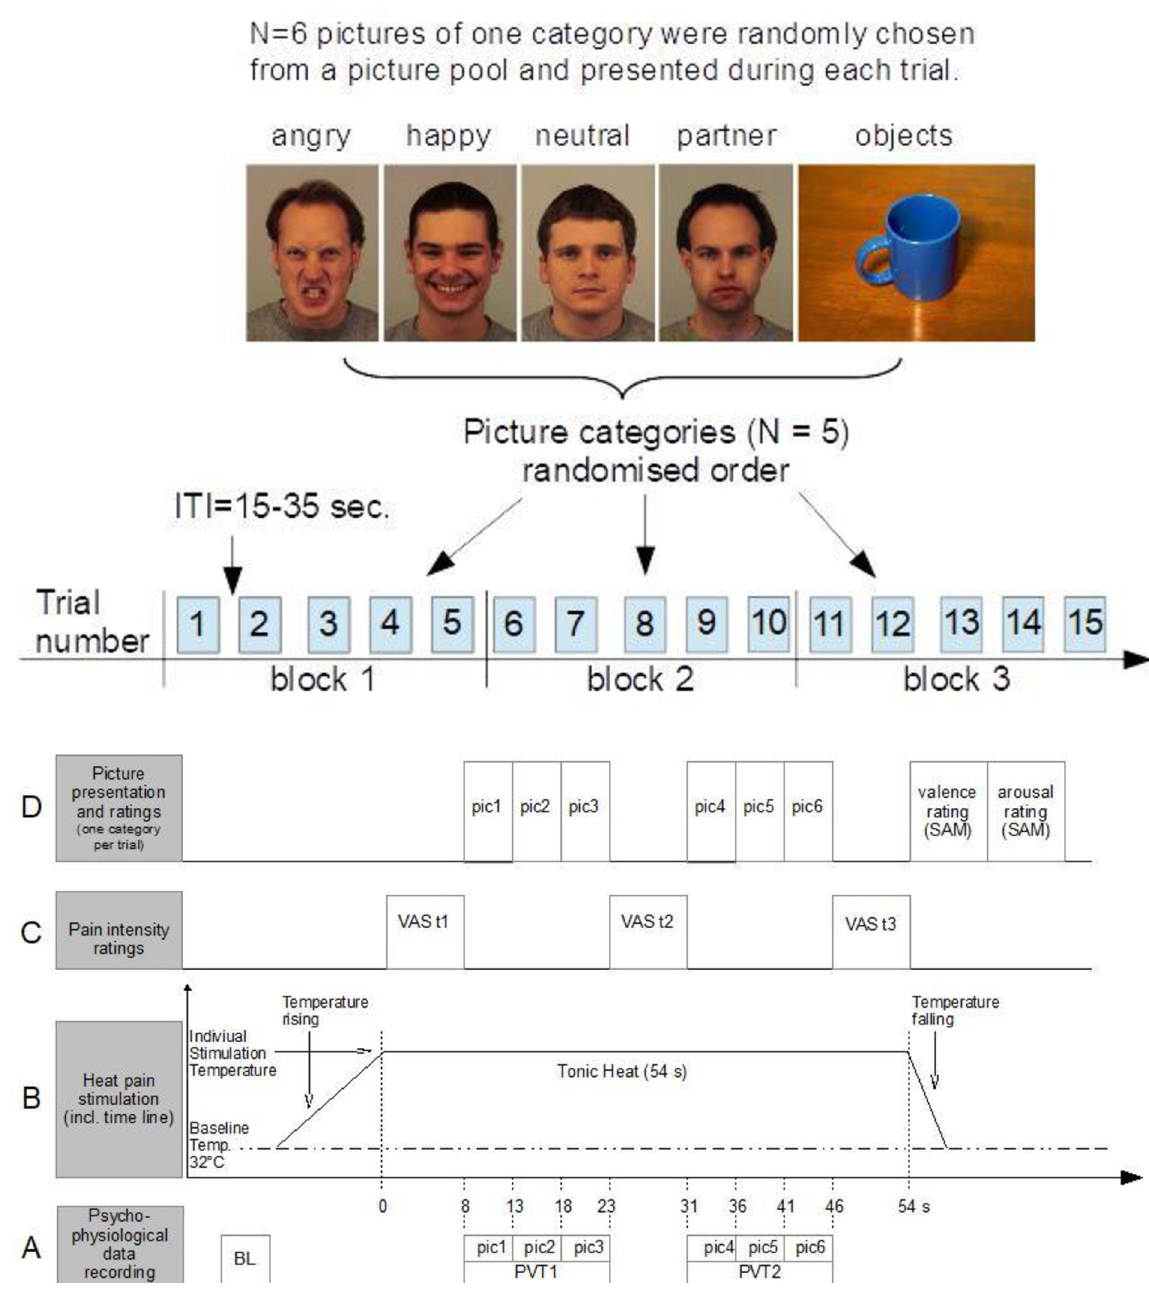
Fig 1. a. Experimental design. Each picture category was presented three times (block 1–3). In each block, the order of the five picture categories was randomized for every participant. Inter-trial-intervals (ITI) varied between 15 and 35 s. Image codes of the schematically displayed pictures (from left to right): AM10ANS, AM31NES, AM07HAS, instead of the picture of the partner the picture AM02NES is presented, due to picture rights, 7009. b. Trial structure. The figure shows the time course of one experimental trial. (A) Psychophysiological data were recorded continuously and later segmented (BL: baseline, 5s before temperature rising, pic1-pic6: 6 5 s intervals during picture presentation, PVT: picture viewing time), (B) heat pain stimulation: starting from a baseline temperature of 32˚C, temperature increased at a rate of 1˚C/s until reaching the individually adjusted stimulation temperature. The target temperature was held constant for 54 s and then returned to baseline temperature at a rate of 8˚C/s, (C) pain intensity ratings on a visual analogue scale (VAS): VAS were shown on the screen for 8 s and participants were asked to rate pain intensity prior to picture viewing (VAS t1), and after each picture viewing time (VAS t2: after pic1-pic3; VAS t3: after pic4-pic6); (D) picture presentation and ratings: valence and arousal ratings were obtained using the self-assessment manikin (SAM). ITI: